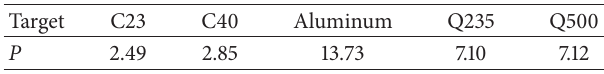
Table 4: Normalized penetration depth when the penetration resistance just reaches